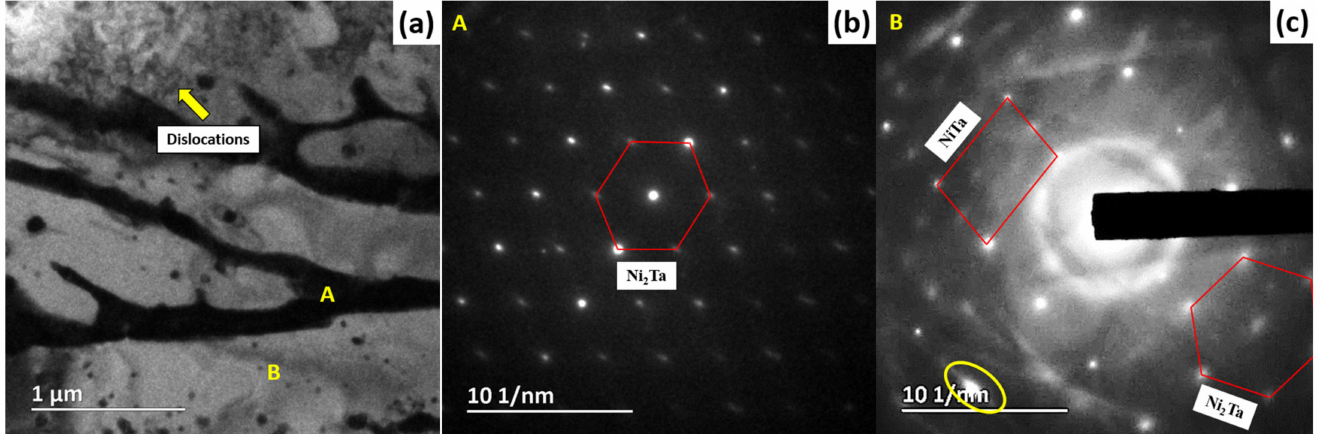
Figure 18. TEM micrographs of an as-fabricated specimen. ( a ) Low-magnification dark-field image; ( b ) SAED pattern of the primary phase “A” in the [111] direction; ( c ) SAED pattern of the secondary phase “B” in the [111 ]